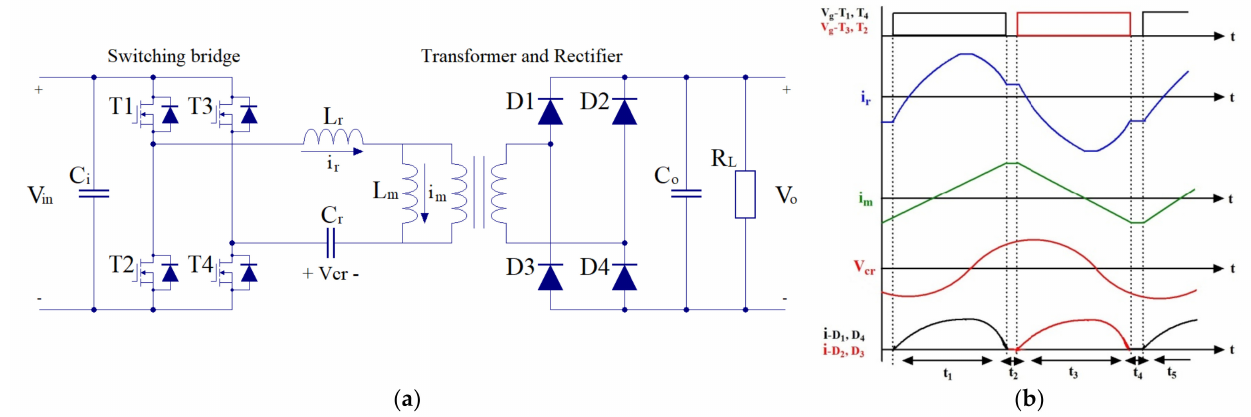
Figure 4. FB-LLC resonant converter with FB rectifier: ( a ) Two inductors and one capacitor forming a resonant circuit; ( b ) Output waveforms of the FB-LLC resonant converter